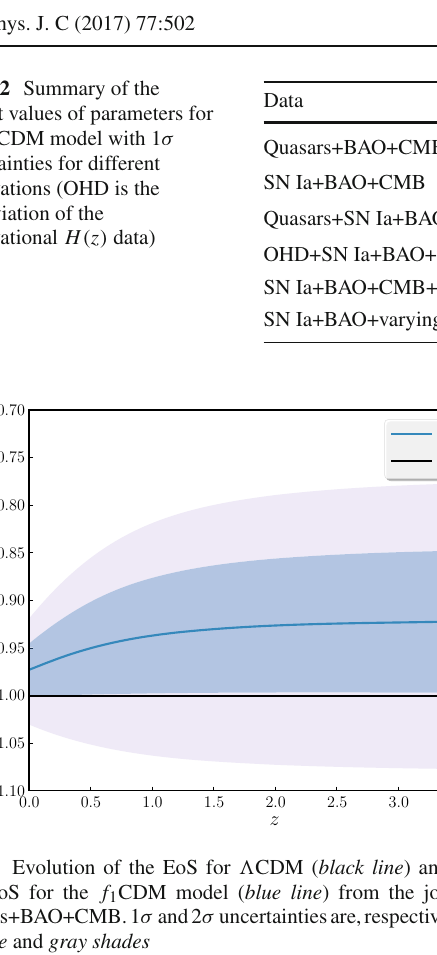
Fig. 3 Evolution of the EoS for (cid:3) CDM ( black line ) and the effec- tive EoS for the f 1 CDM model ( blue line ) from the joint analysis quasars+BAO+CMB.1 σ and2 σ uncertaintiesare,respectively,denoted by blue and gray